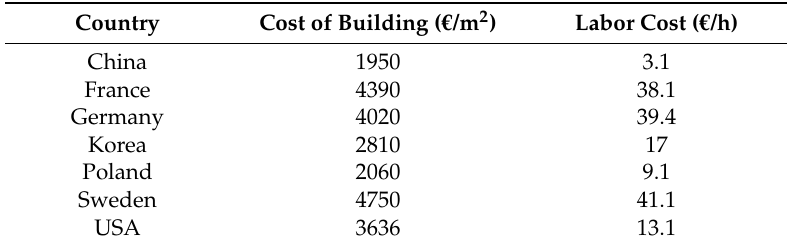
Table 2. Key parameters for manufacturing countries. USA: United States. Country Cost of Building ( € /m 2 ) Labor Cost ( € /h) China